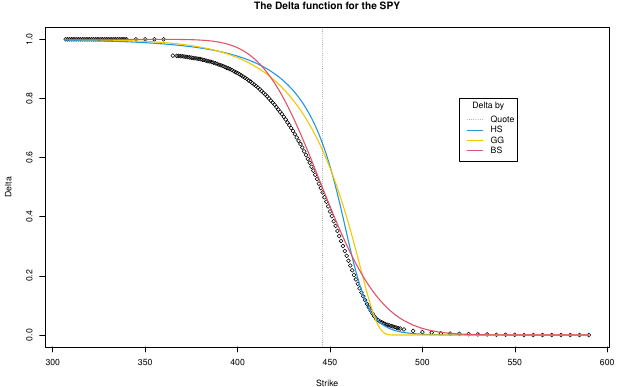
Figure 3. The SPY case—the calculated delta functions under each of the pricing models, HS, GG and BS, along with the quoted delta per each strike K in the 15 October 2021 option